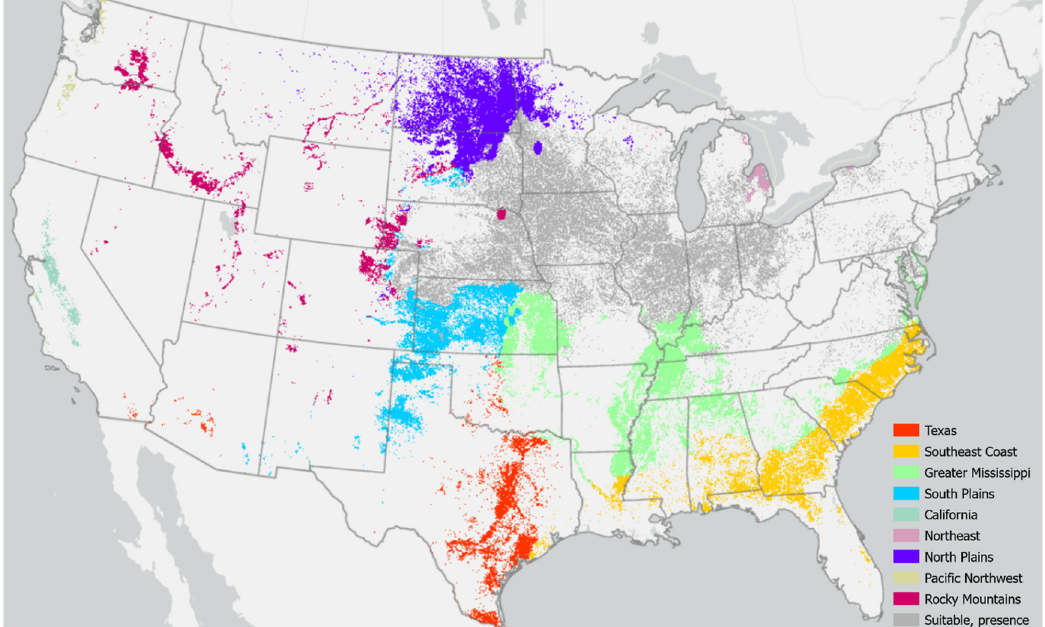
Figure 9. Map of regions unsuitable for corn cultivation (unsuitable presence) as predicted by the Maxent model. Areas of unsuitable presence were clustered by geographic proximity and the five most influential bioclimatic variables via multivariate clustering. This process produced nine unique regions of unsuitable presence with unique bioclimatic characteristics. Only clusters with more than 1 million acres were included in Figure 10.